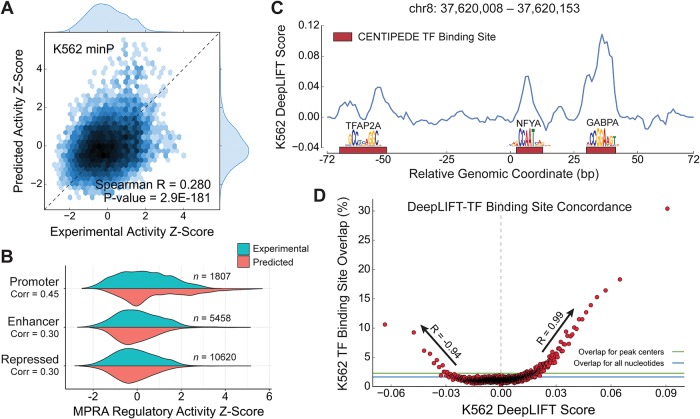
MPRA-DragoNN distinguishes active regulatory sequences at high resolution.(A) Predicted regulatory activity z-scores vs. experimental activity z-scores for the K562 minP task. (B) Distributions of experimental and predicted regulatory activities for different ChromHMM-inferred chromatin states. (C) K562 DeepLIFT nucleotide score track for a strongly activating regulatory sequence (top 0.1%) containing three TF binding sites (red) as identified by the CENTIPEDE algorithm. All three TFBSs are detected with statistical significance (Mann-Whitney U test). (D) Nucleotides with strong (in absolute value) DeepLIFT scores are more likely to overlap with TF binding sites than control sequences (blue: all nucleotides, green: DNase peak centers). This trend holds for both positive (R = 0.99) and negative scores (R = −0.94).